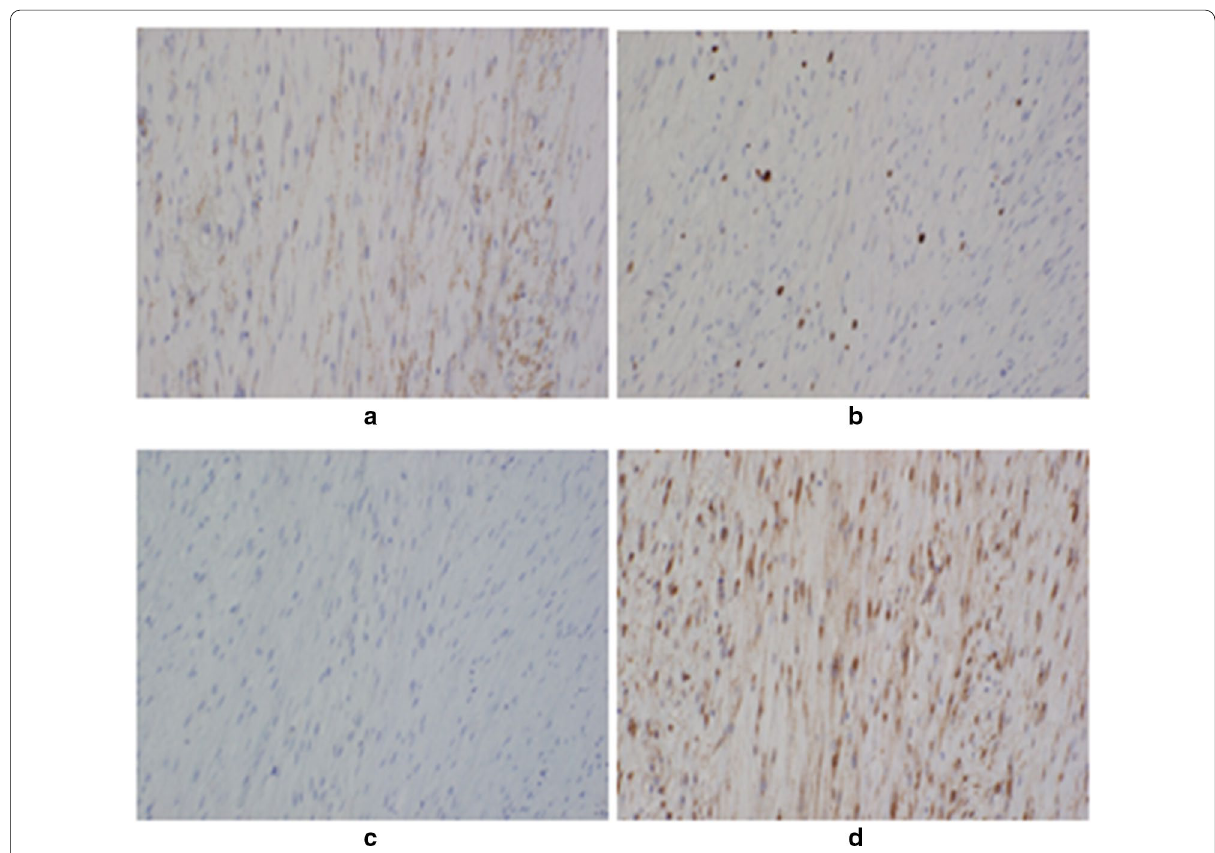
Fig. 5 Immunohistochemistry demonstrating positive staining for smooth muscle actin (α-SMA). ( demonstrating positive staining at low power (3~5%) for Ki67 ( ( 200) ( c ). Immunohistochemistry demonstrating negative staining in the nucleus for β-catenin ( ×